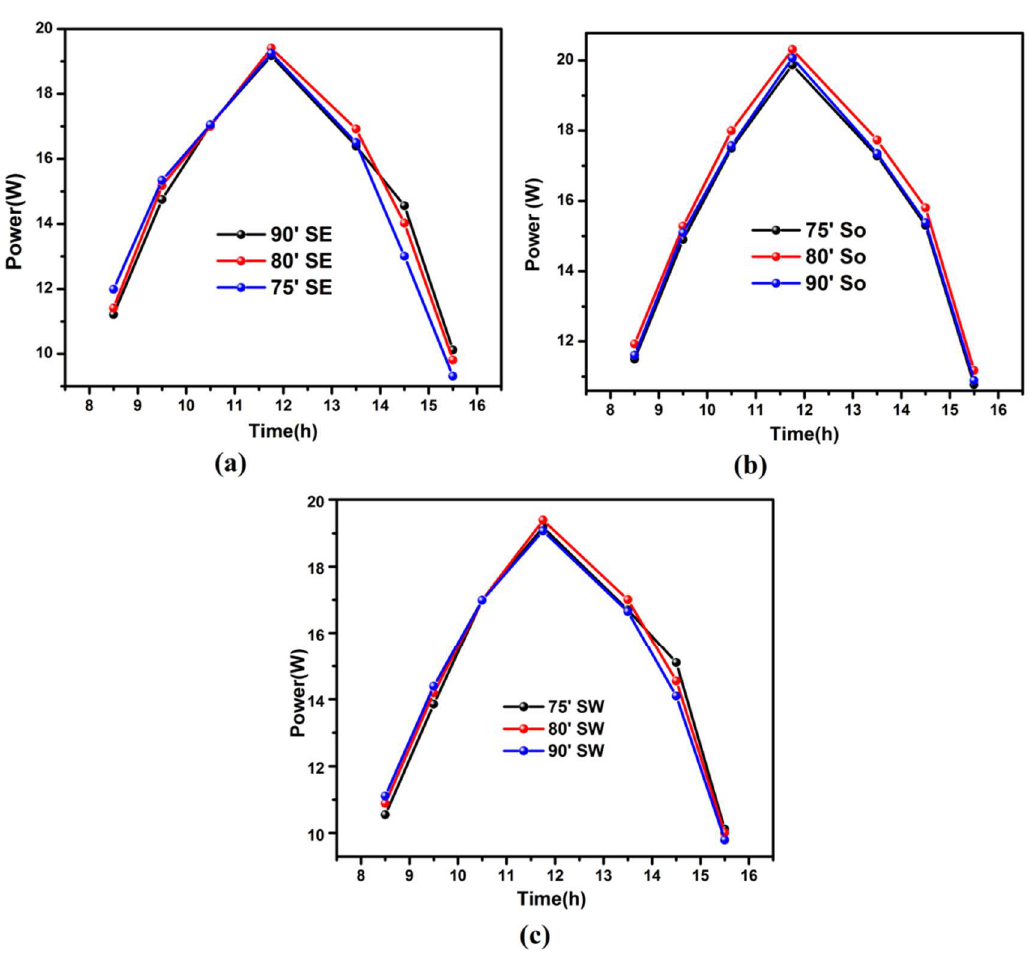
Figure 15. Output power of PV ( a ) south 0°; ( b ) south-east (30° from south towards east);( c ) south-west (30° from south towards west).